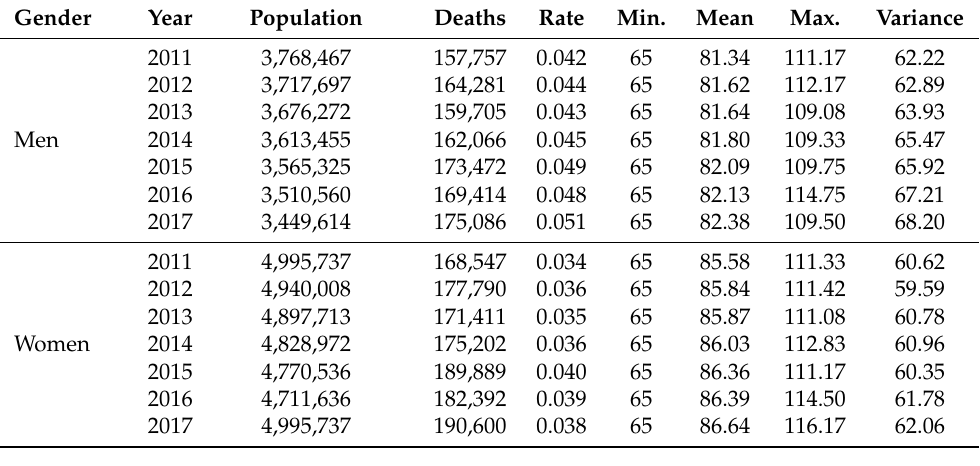
Table 1. Descriptive statistics of age-at-death (in years) for the population aged 65 or over in Spain (2011).